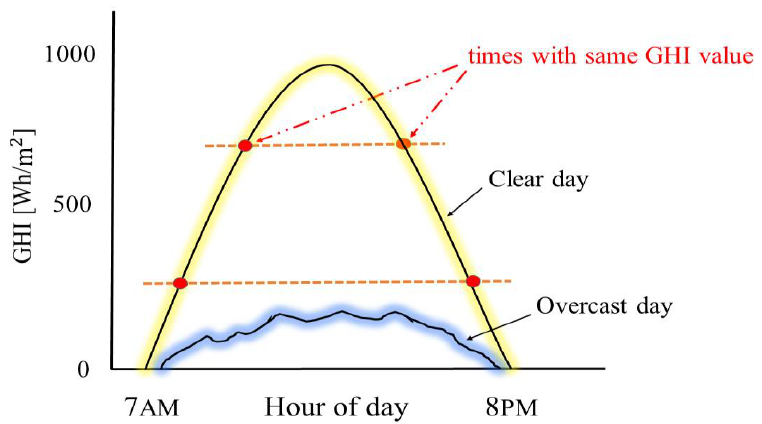
Figure 2. GHI variation on a clear and an overcast day.